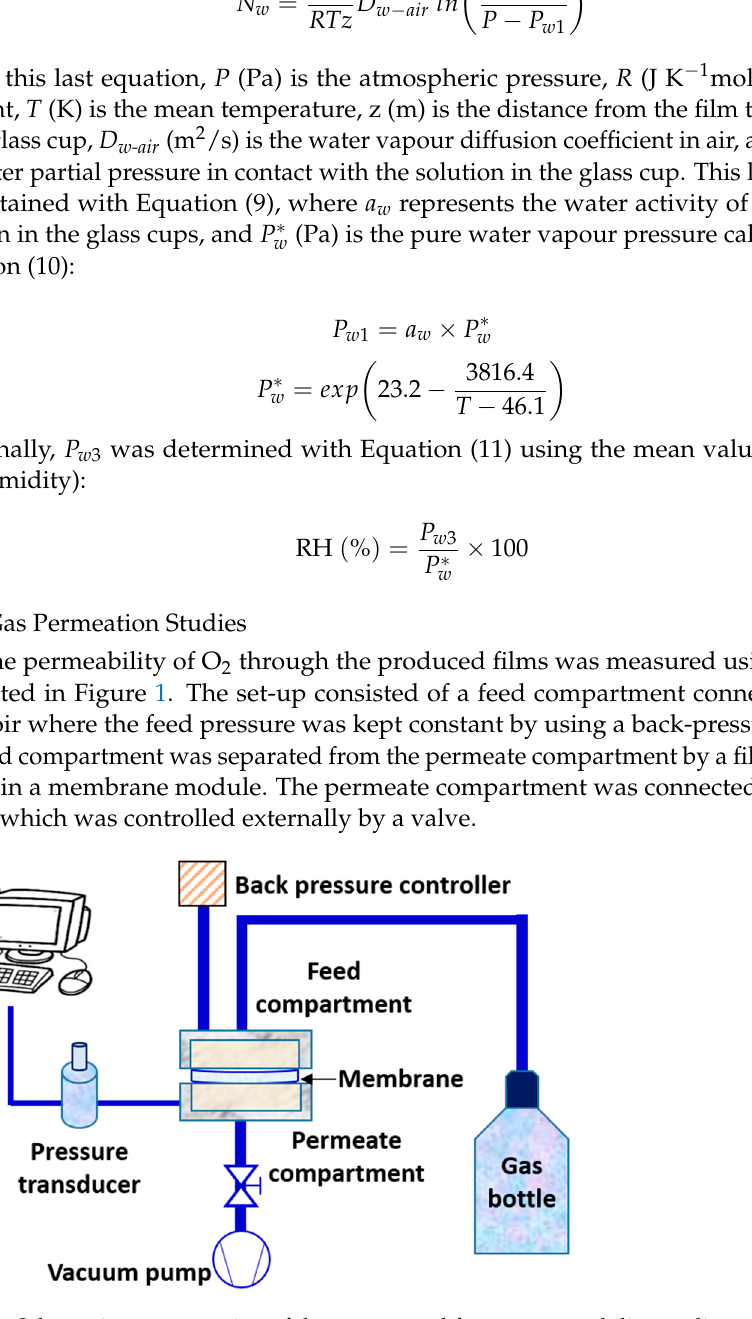
Figure 1. Schematic representation of the set-up used for gas permeability studies.